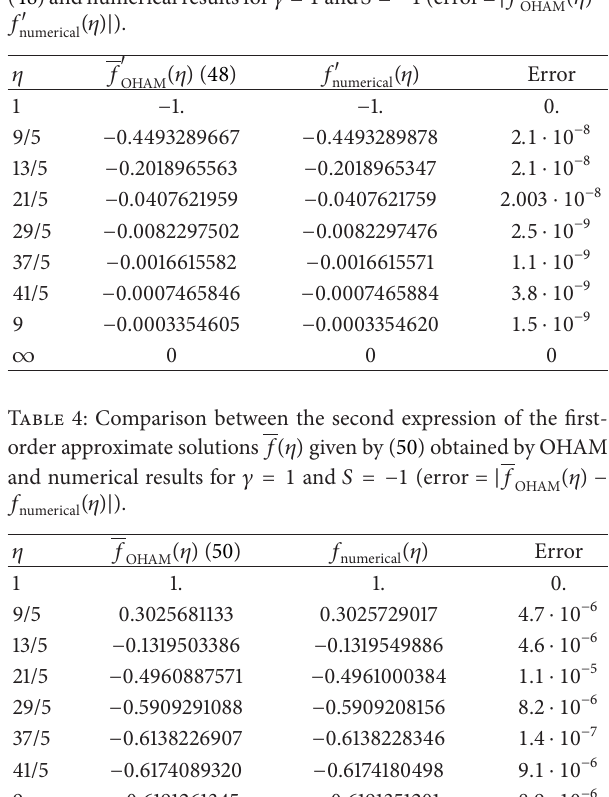
󸀠 (𝜂) obtained from 󸀠 (𝜂)− OHAM